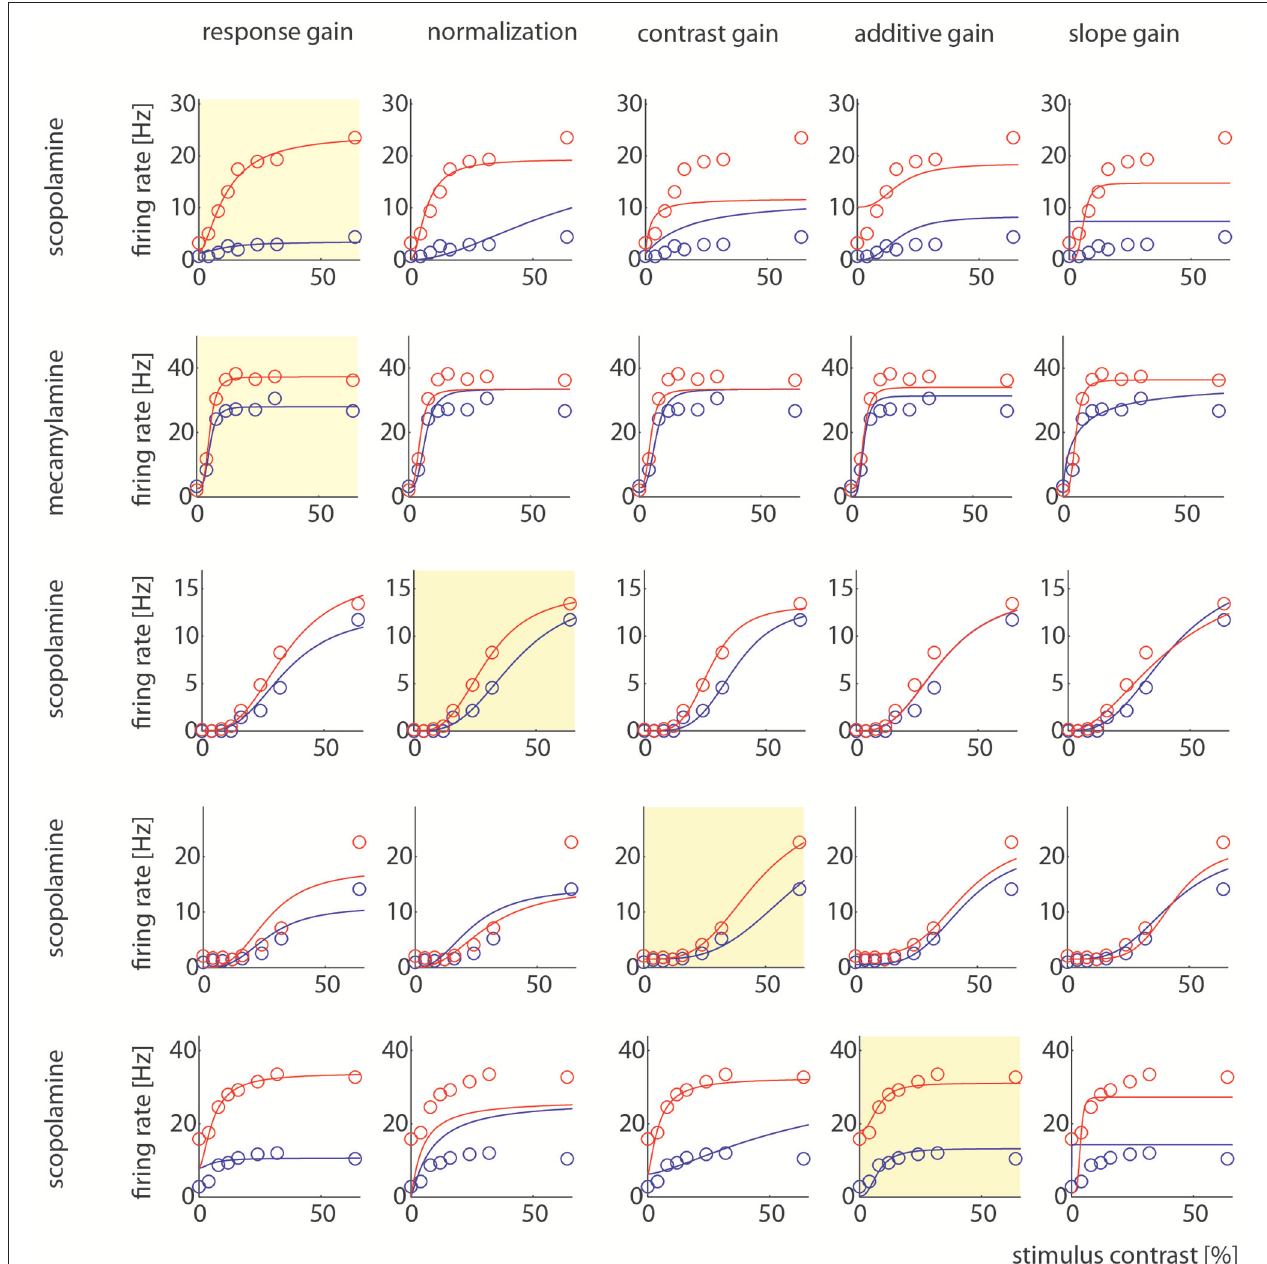
FIGURE 7 | Model comparison for example cells. Each row shows how well the 5 different models could be fitted to the control and drug applied activity levels. The yellow insets highlight which particular model yielded the largest AIC weight. The different models are named at the top, the different drugs used in the particular recording are indicated on the